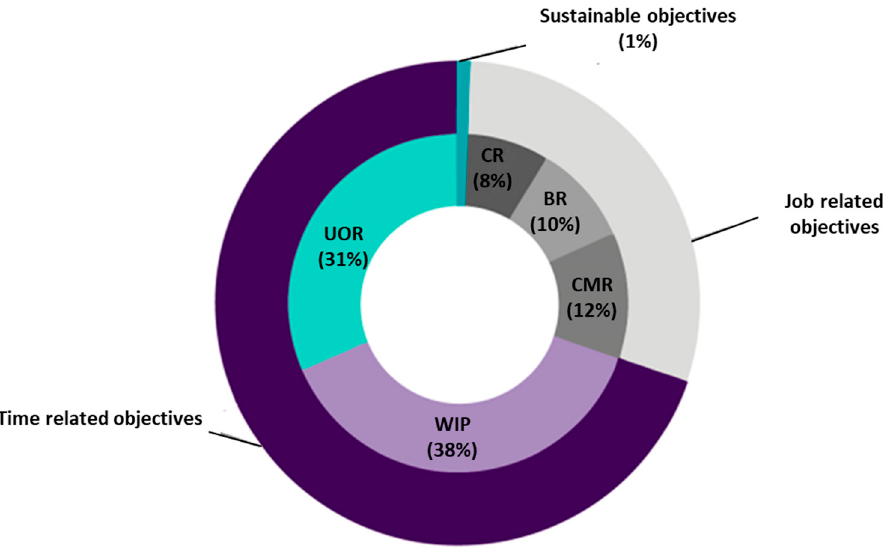
Figure 6. Distribution by objective function categories. UOR: utilization of resources; WIP: work in process; CMR: costumer related; BR: balancing related; CR: cost related.